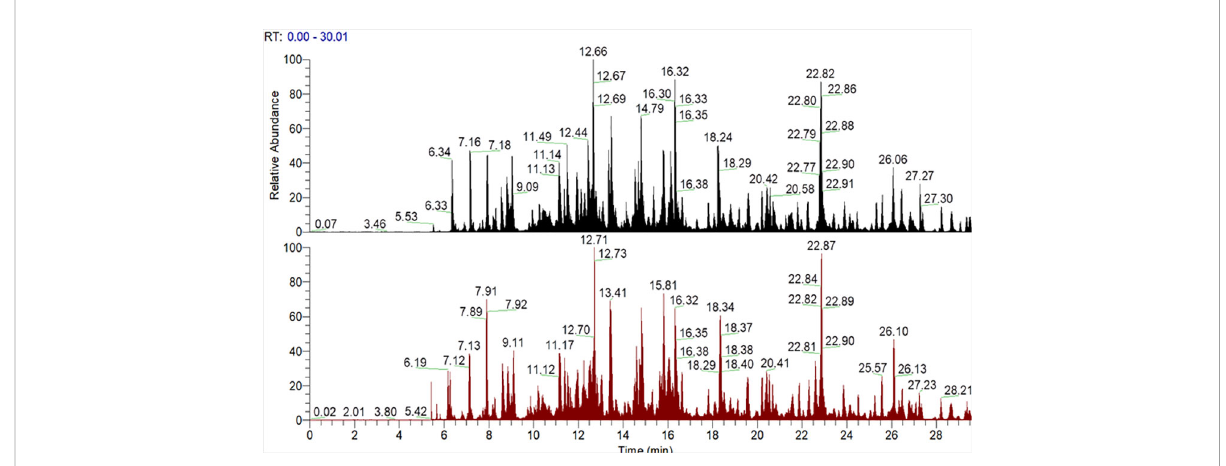
FIGURE 2 Mass spectrometry signal total ion fl ow chromatogram. Note: the abscissa is the elution time and the ordinate is the peak intensity. The fi gure above is Tf; the following fi gure shows the AGE-Tf (500 mM) sample, that is, AGE-Tf with 500 mM